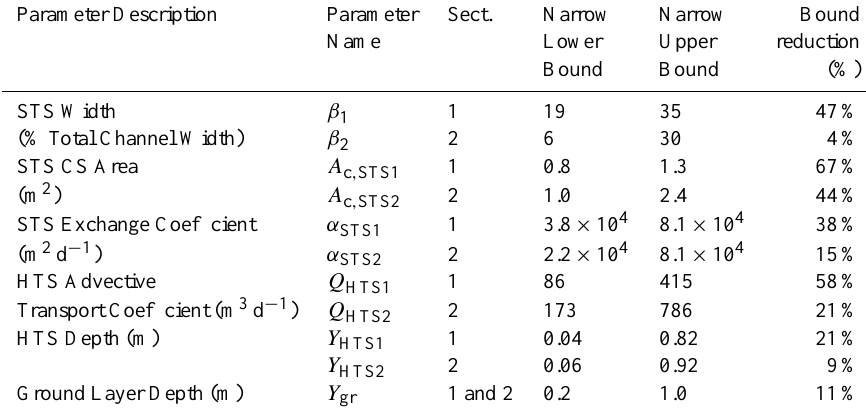
Table 4. The 11 calibration parameters distributed between two sites, the narrowed upper and lower parameter bounds, and associated percent reduction in parameter range compared to the a priori values shown in Table 2. The a priori range was the same for each section, but the narrowed bounds resulting from calibration varied between Sects. 1 and 2. Parameter Description Parameter Sect. Narrow Narrow Bound Name Lower Upper reduction Bound Bound (%) STS Width β 1 1 19 35 β 2